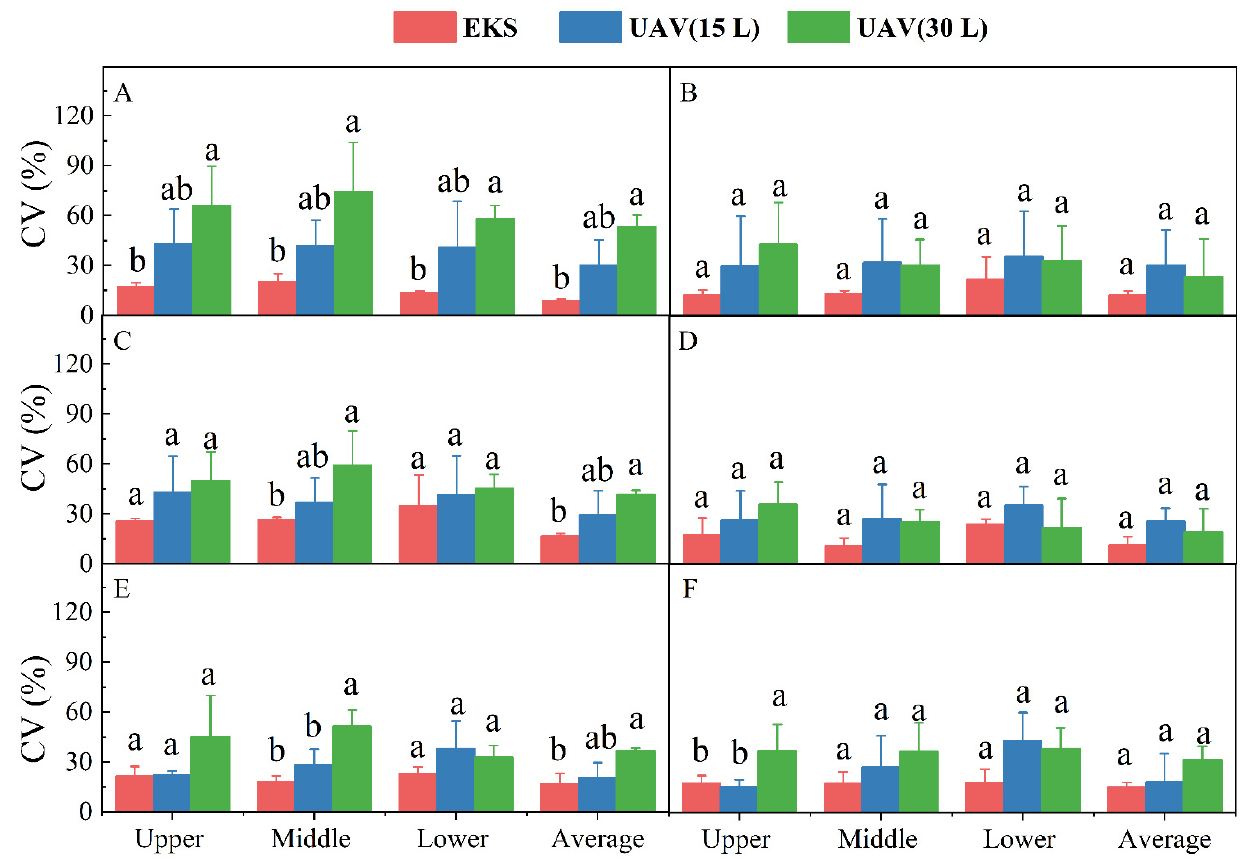
Figure 5. CV of droplet coverage, deposition density, and deposition in different positions in 2020. Parallel ( A ) and vertical ( B ) to the flight direction for the droplet coverage rate. Parallel ( C ) and vertical ( D ) to the flight direction for the droplet deposition density. Parallel ( E ) and vertical ( F ) to the flight direction for the droplet deposition. One-way ANOVA followed by Tukey test was used, and different letters above the bars indicated the significant differences ( p < 0.05) among treatments. Bars are the standard deviation of three replications.